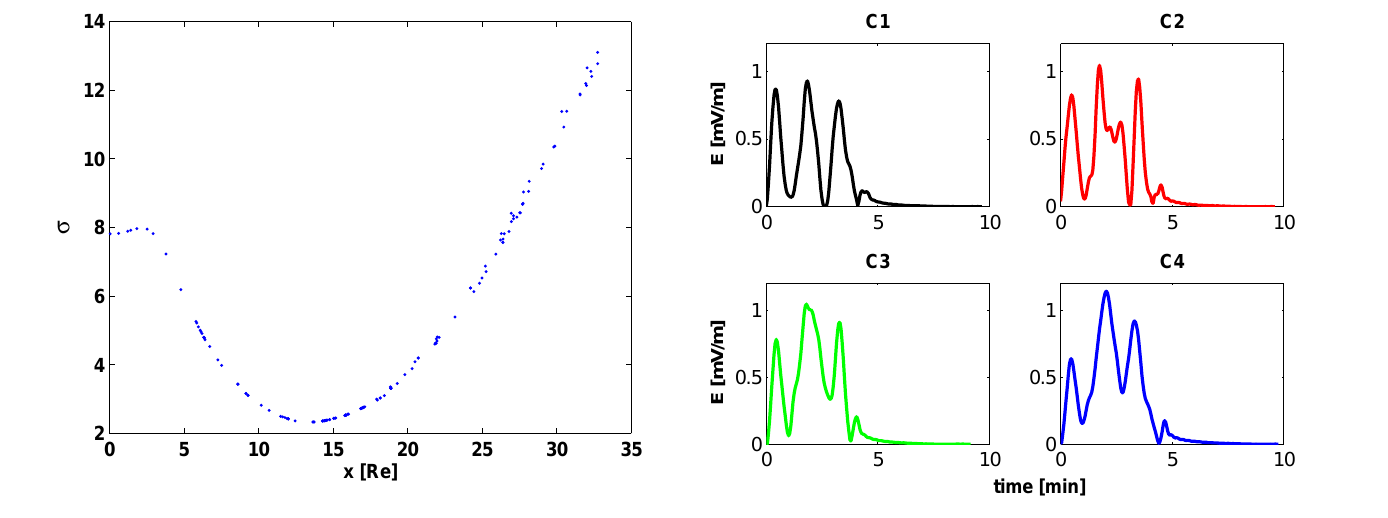
Fig. 5. Reconstructed electric